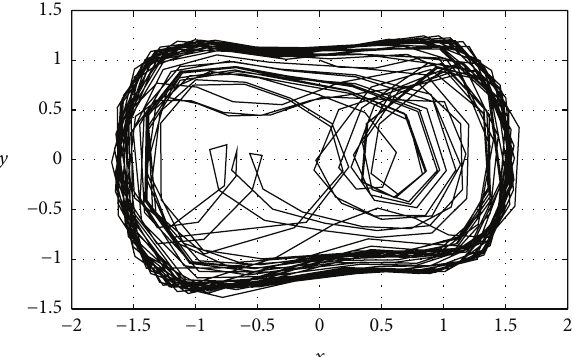
Figure 3: 3D Duffing chaotic system phasediagram in the 𝑥𝑜𝑦 plane projection.